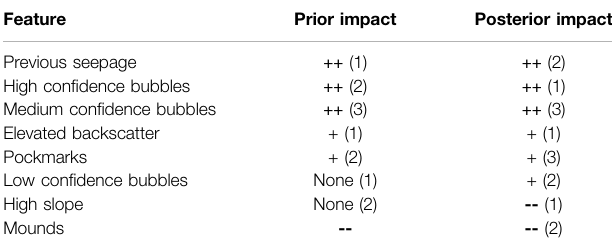
TABLE 5 | Relative impacts of individual features at beginning and end of